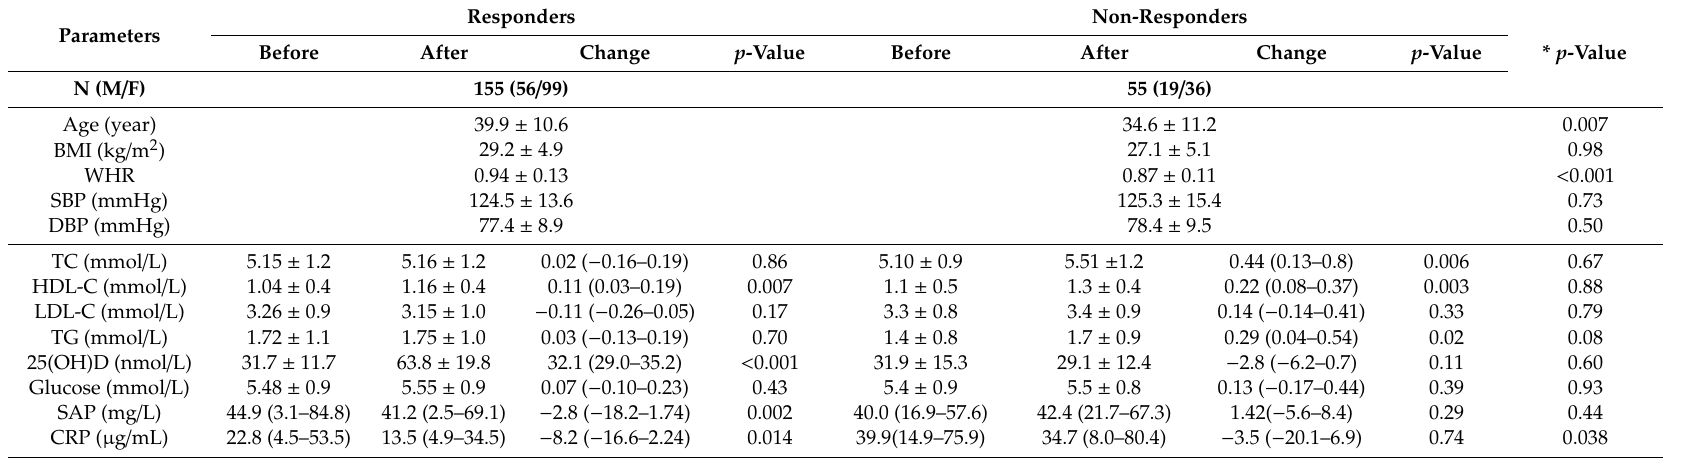
Table 1. Clinical characteristics of study participants at baseline and after 6-month